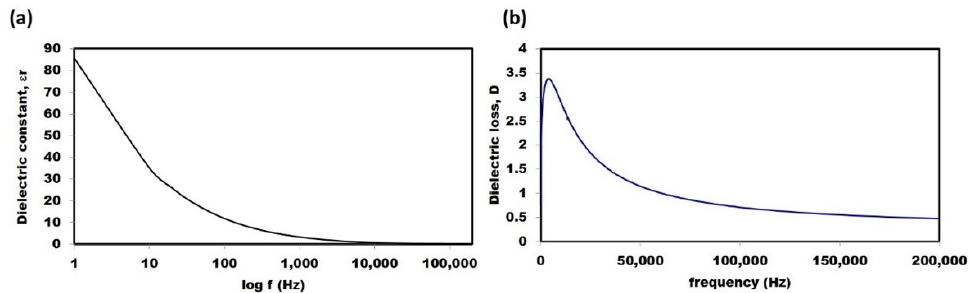
Figure 7. Electrical properties of ZnO NS; ( a ) dielectric constant and ( b ) dielectric